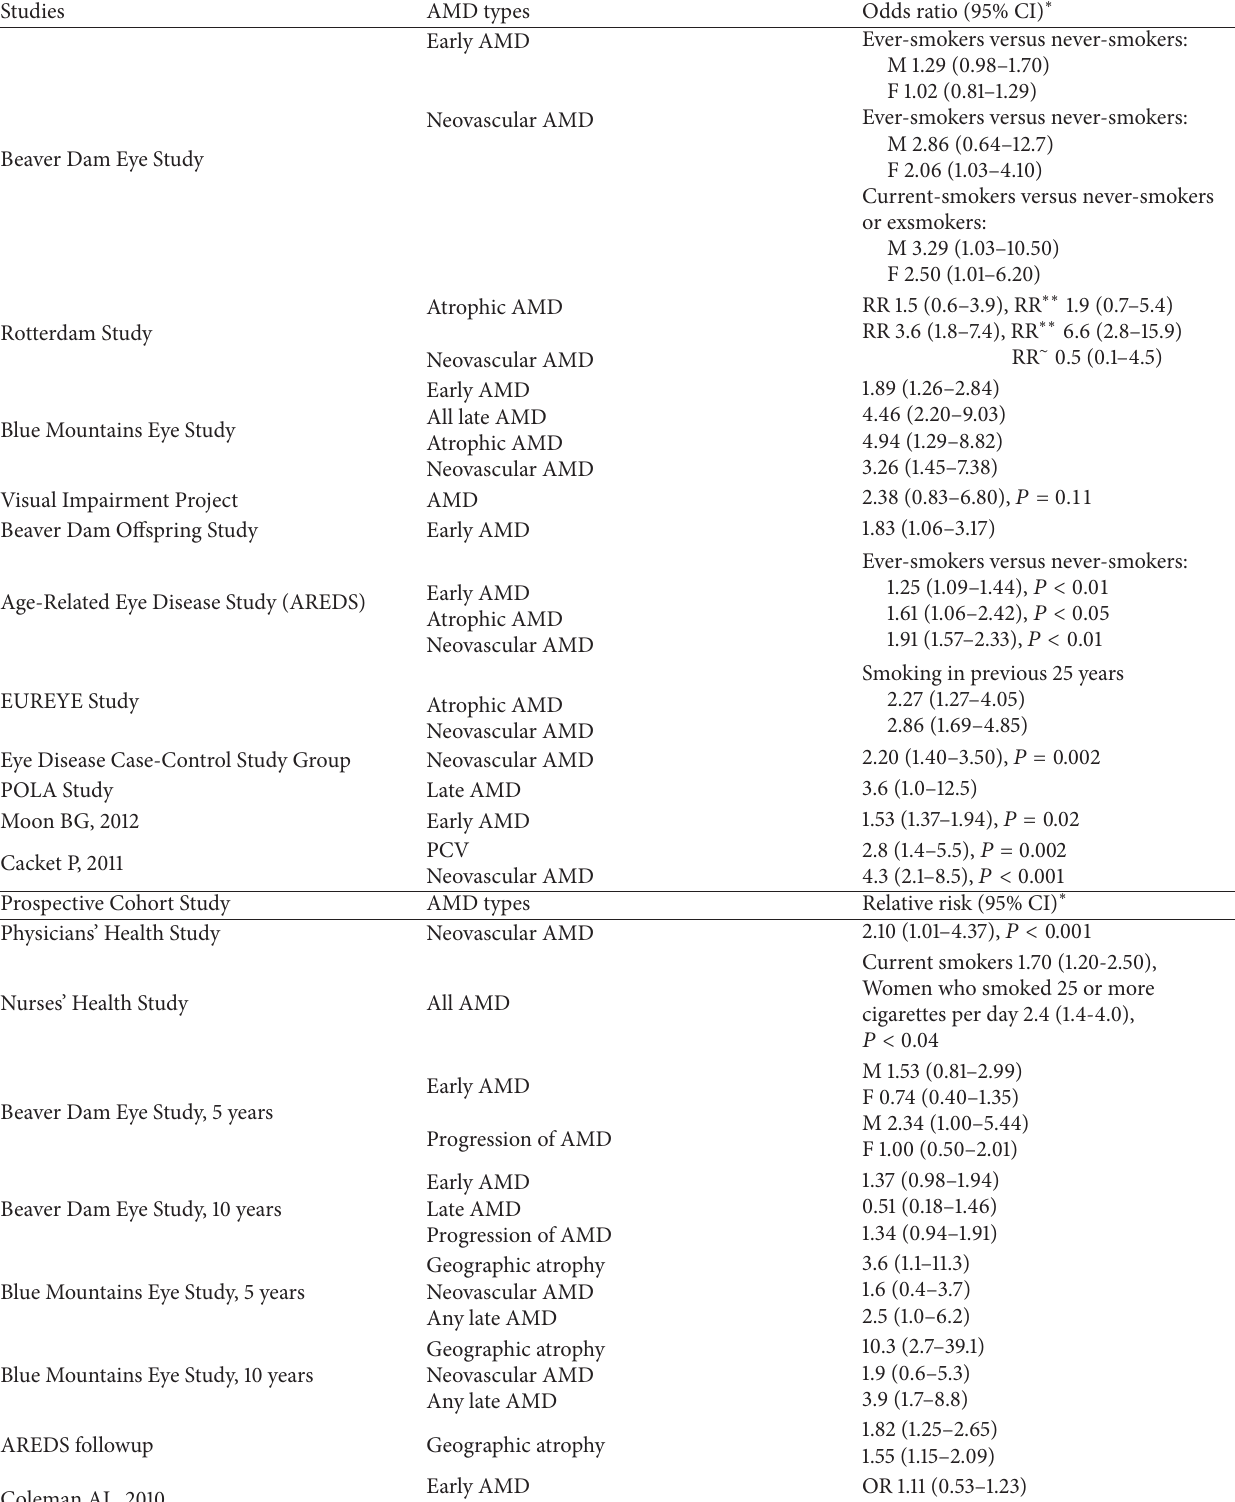
Table 2: Cross-sectional and prospective cohort studies examining the association between smoking and AMD: current-smokers versus never-smokers ∗